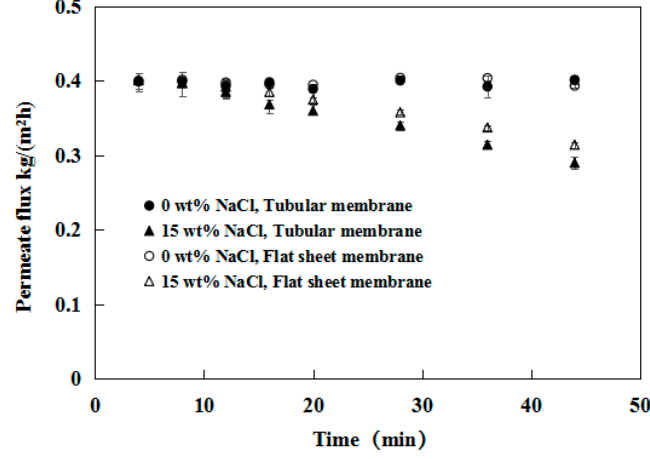
Figure 3. Effect of NaCl concentration and operation time on the water flux in binary NaCl–water solutions. (Feed: NaCl/water solution n).